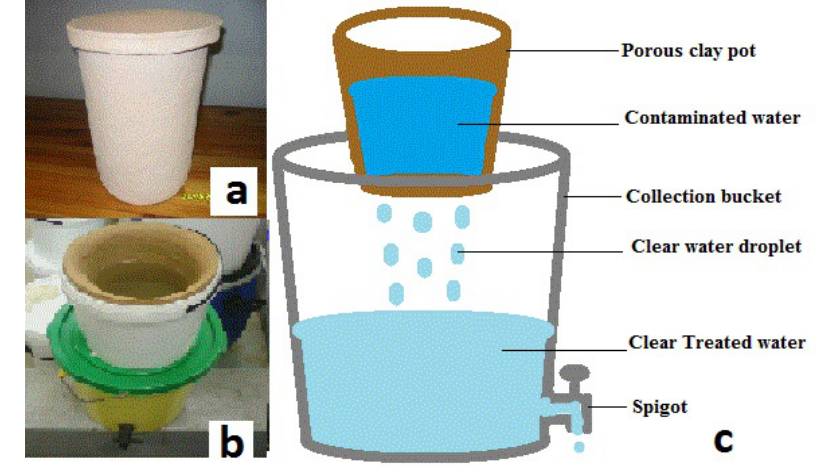
Figure 1. Illustration of the SIPP Filter: ( a ) the silver impregnated clay pot that serves as the filtering unit; ( b ) the clay pot fitted into a 10 L bucket (receptacle) and placed on top of a 25 L collection vessel; ( c ) schematic diagram of a complete SIPP